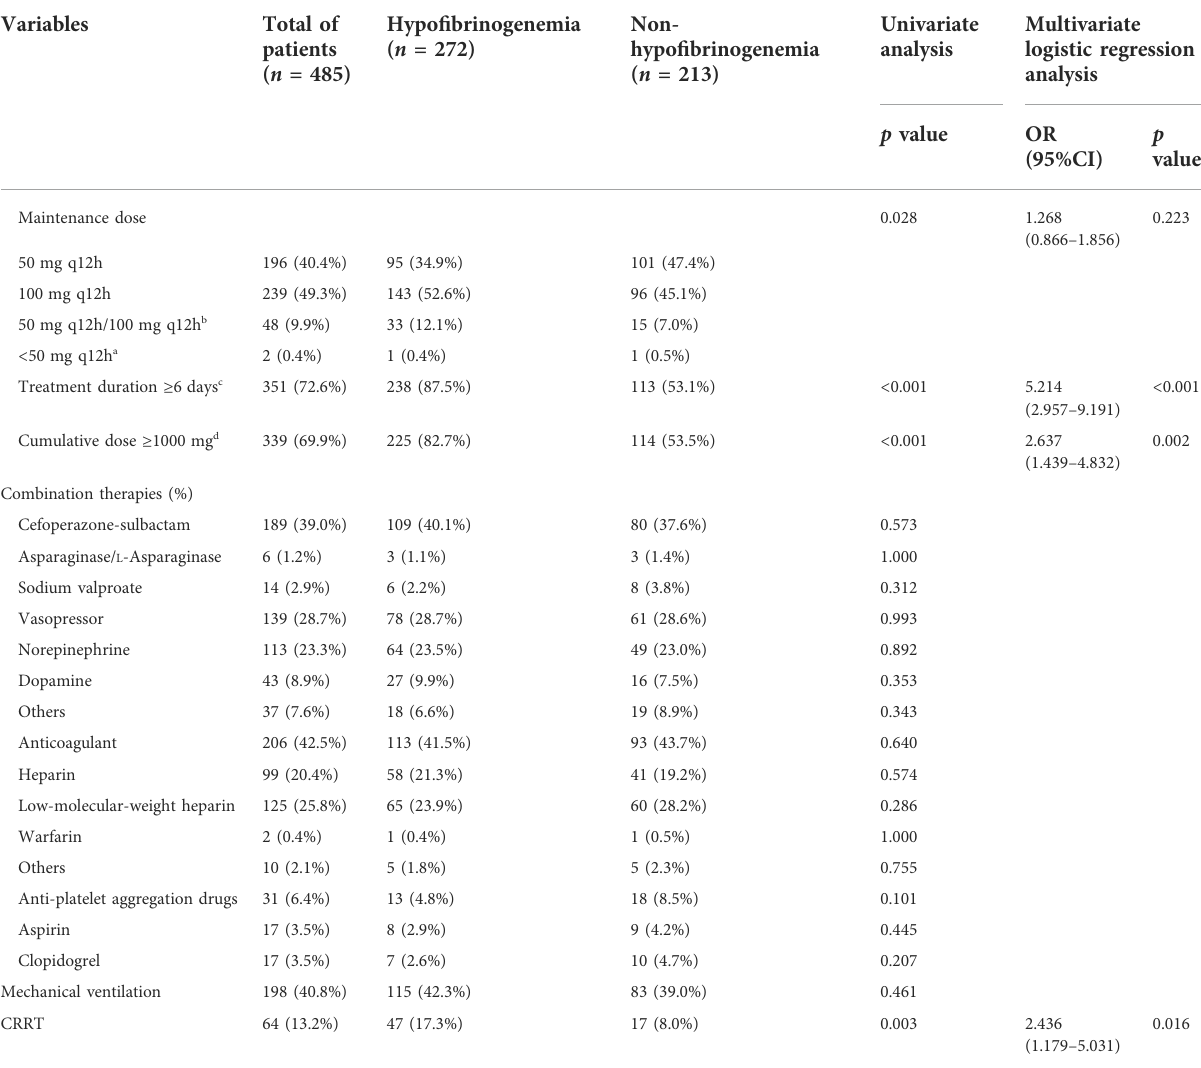
TABLE 4 ( Continued ) Comparison of demographic and clinical characteristics of patients with hypo fi brinogenemia and non-hypo fi brinogenemia during tigecycline